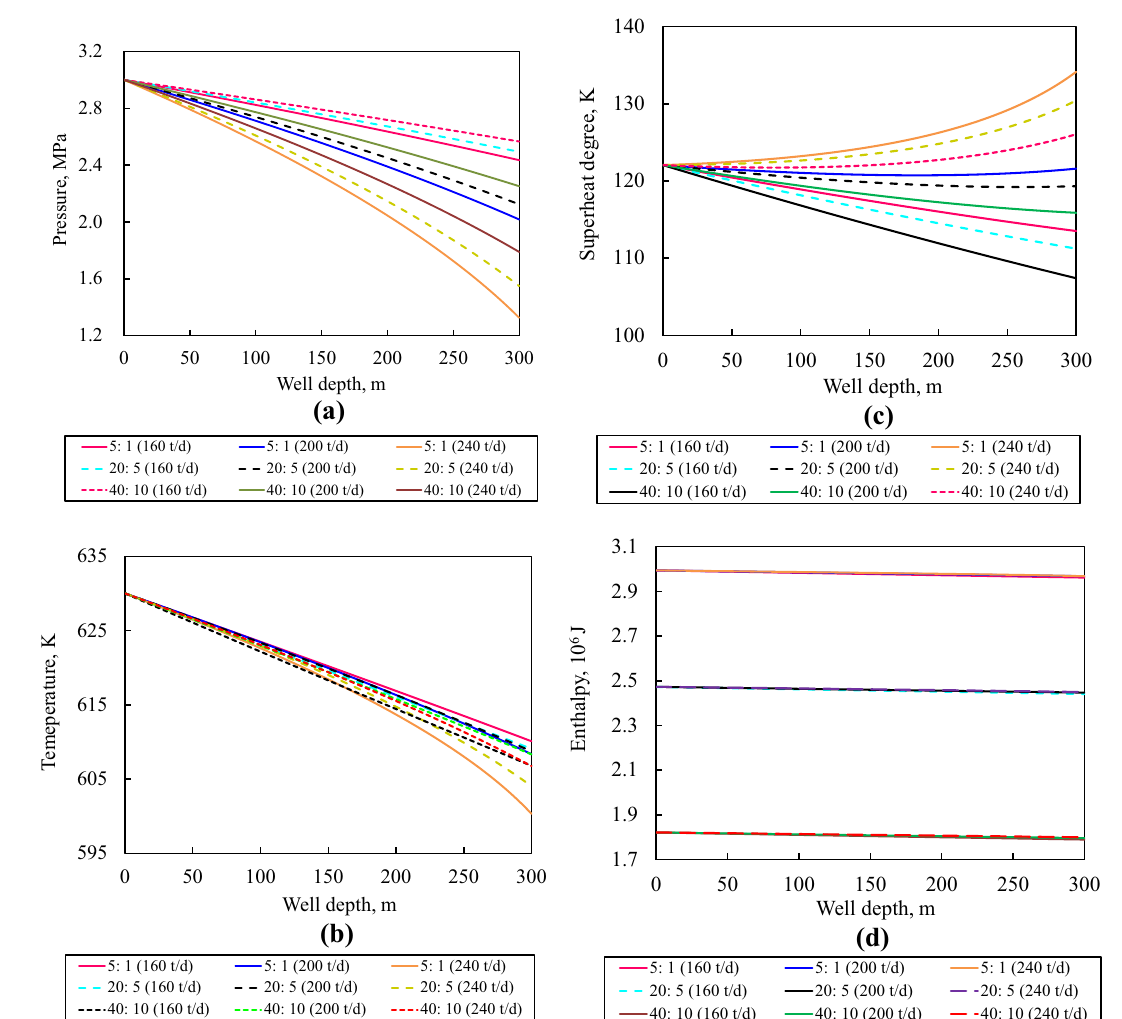
Fig. 3 Effect of injection rate on the profiles of thermophysical properties of SMTF in wellbores under various mass content of non-condensing